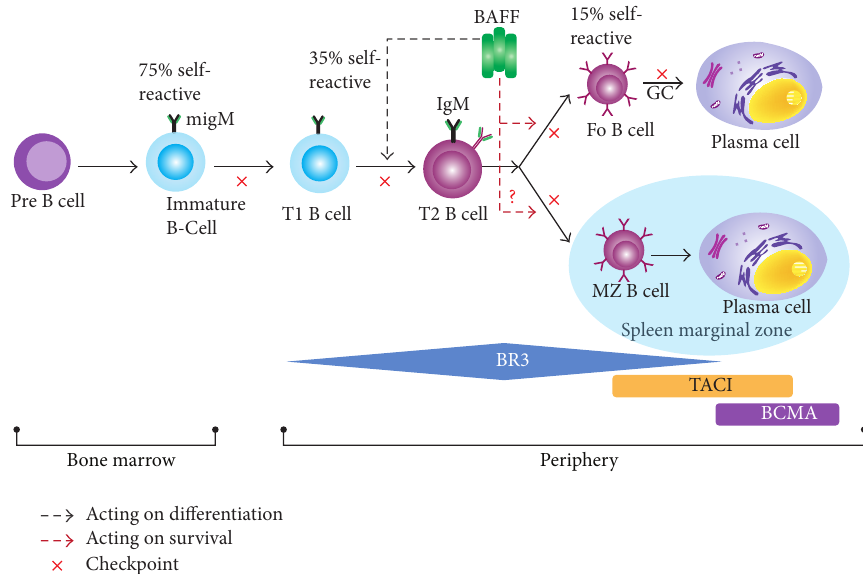
Figure 8: BAFF receptor cell surface expression and self-tolerance during B cell ontogenesis. Data indicate the proportion of self-reactive B cells at specific B cell stages before or after checkpoints as determined in the anti-HEL/HEL transgenic models. Fo: follicular; GC: germinal center; Imm: immature; MZ: marginal zone; Pre: precursor; T1 or 2: transitional type 1 or